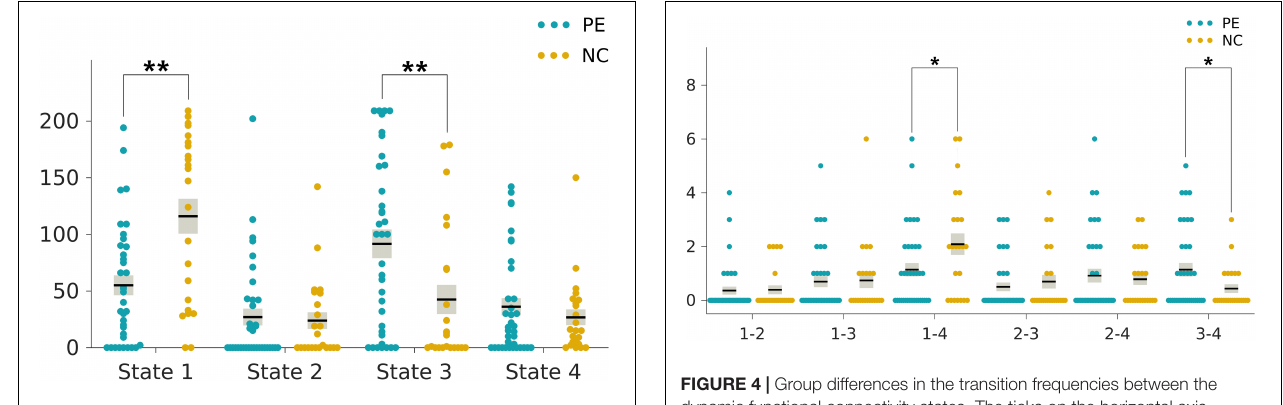
FIGURE 3 | Group differences in reoccurrence times of each dynamic functional connectivity state. The reoccurrence times of each individual in the lifelong premature ejaculation (LPE) and normal control (NC) groups are presented in blue and khaki, respectively. For each group, the black line indicates the mean reoccurrence times in that group, and the light gray rectangle covers the data within one standard error above and below the mean. The pairs of groups with asterisks indicate significant differences between them: ** p < 0.05, Bonferroni corrected.